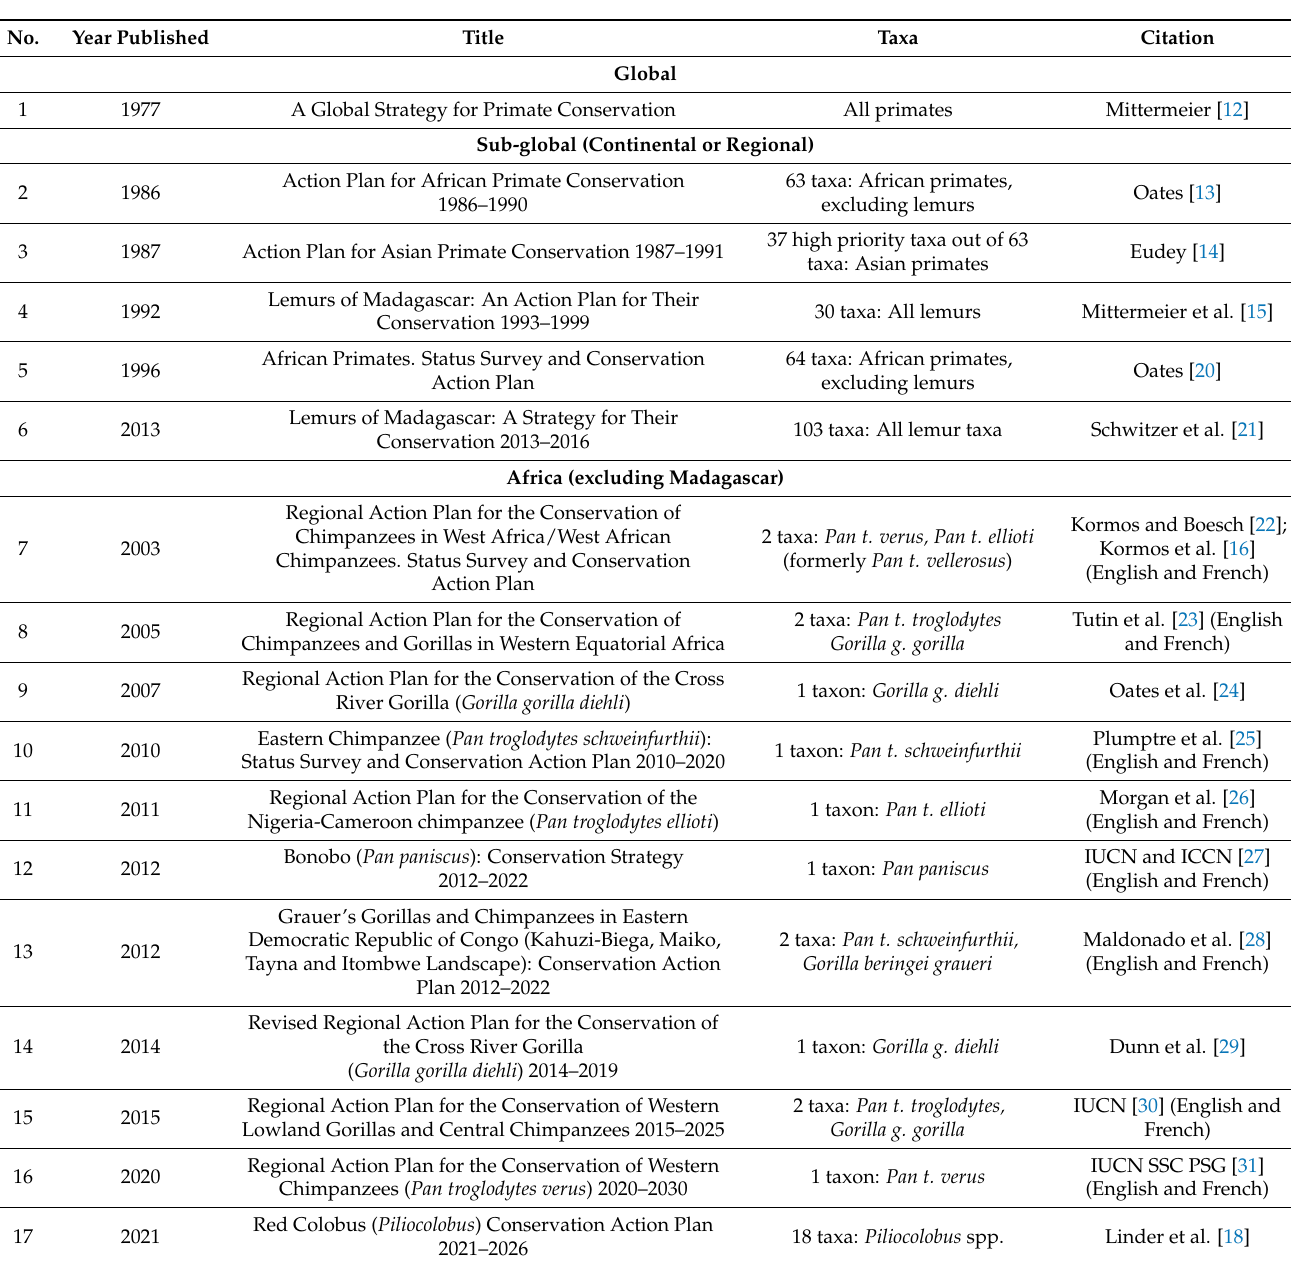
Table 1. List of IUCN SSC PSG primate conservation action plans. In addition to these listed below, there are many other primate action plans which have been published, often with support from IUCN SSC PSG members; a representative selection is listed in Table